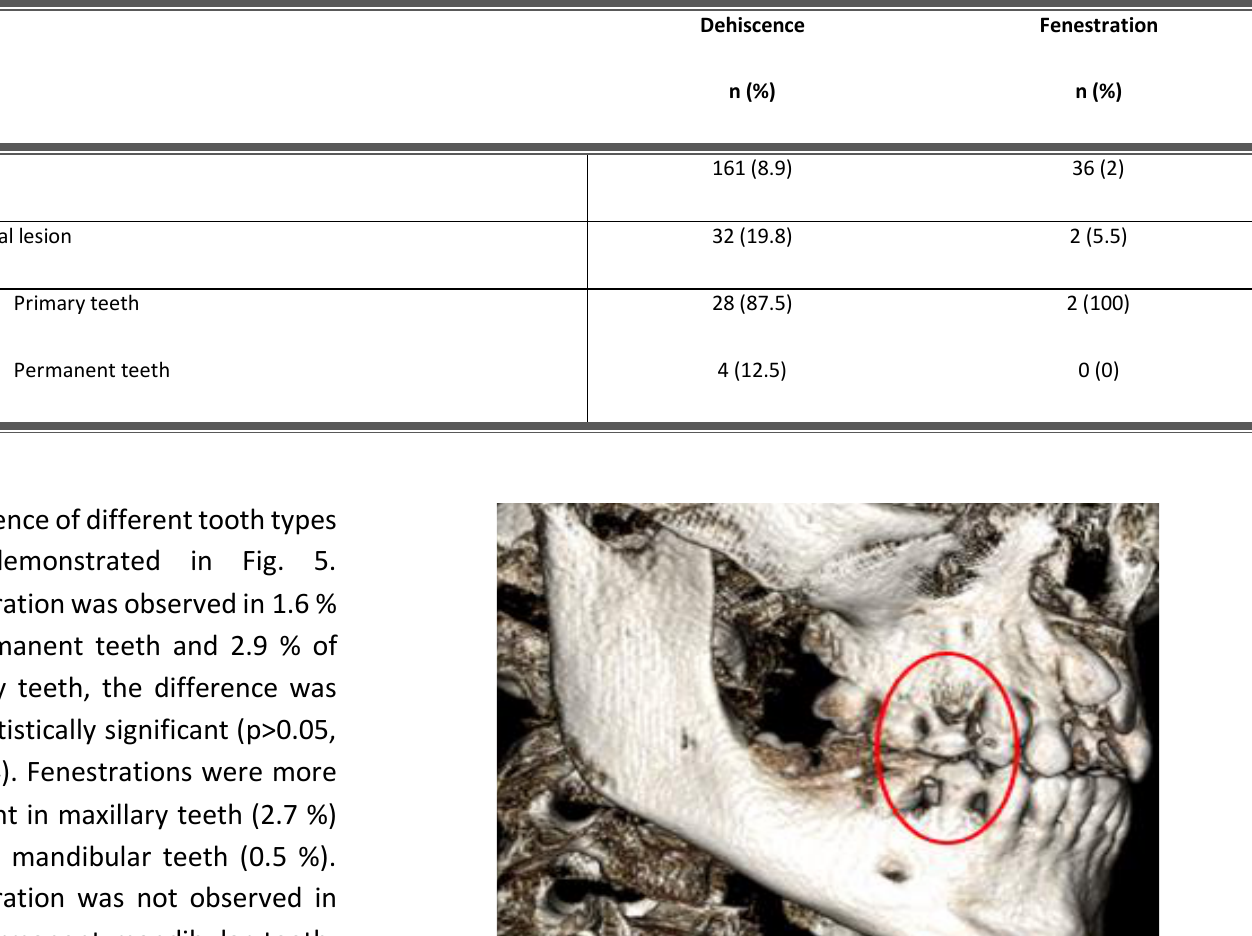
Table 5. Distribution of periapical lesion in teeth with dehiscence and fenestration: